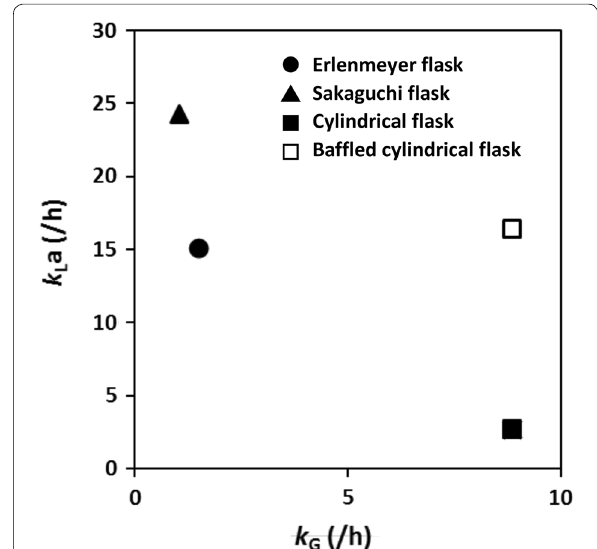
Fig. 3 Relationship between k L a and k G in various shake